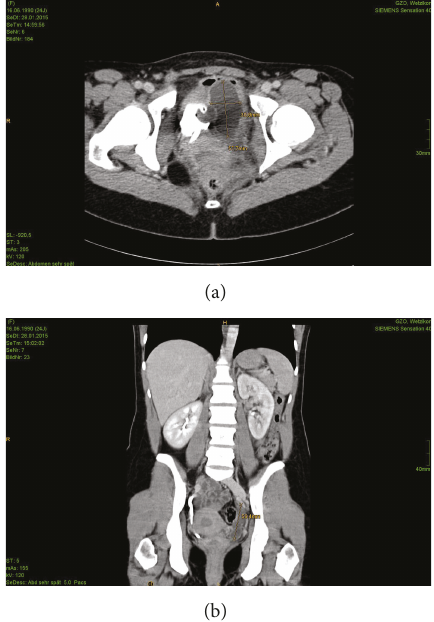
Figure 3: Transversal (a) and frontal (b) section of the patient’s CT scan. In (a), the bladder, filled with contrast and a transurethral catheter being in place, can be found shifted to the right patient’s side. The ureterocele right next to the bladder measures about 3 × 6 cm.(b)showsthedilatedleftureterandthattherewasnoincidence for a duplex renal